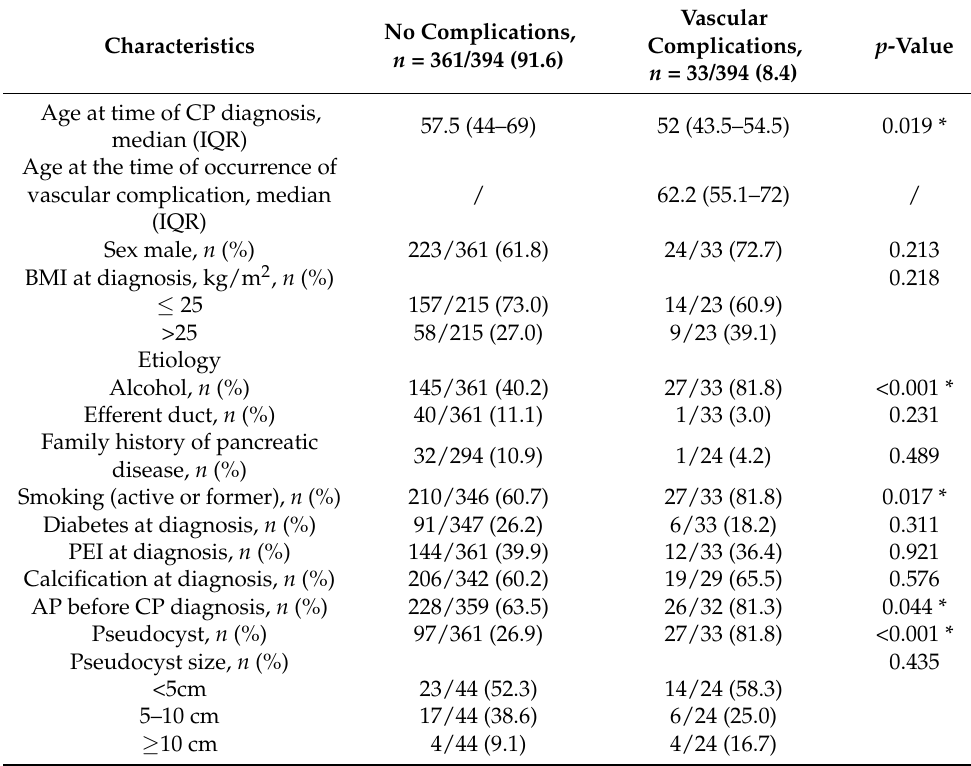
Table 2. Demographic and clinical baseline characteristics of patients with chronic pancreatitis categorized by presence and type of vascular event.